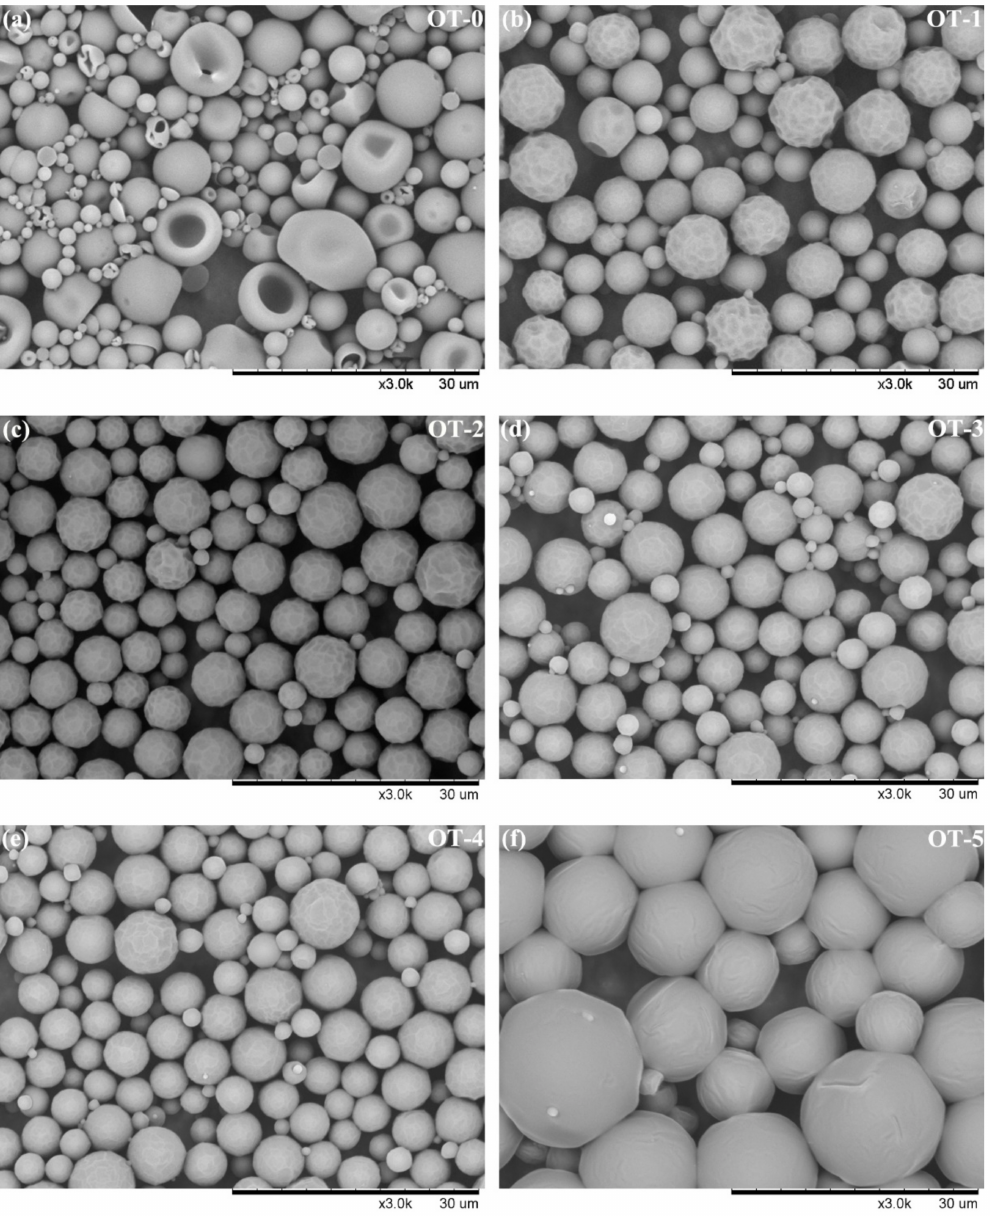
Figure 2. SEM images of composite microcapsules with di ff erent n-Octadecane (OD) to thyme oil (TO) ratio: ( a ) 0:12; ( b ) 3:1; ( c ) 4:1; ( d ) 5:1; ( e ) 6:1; ( f )